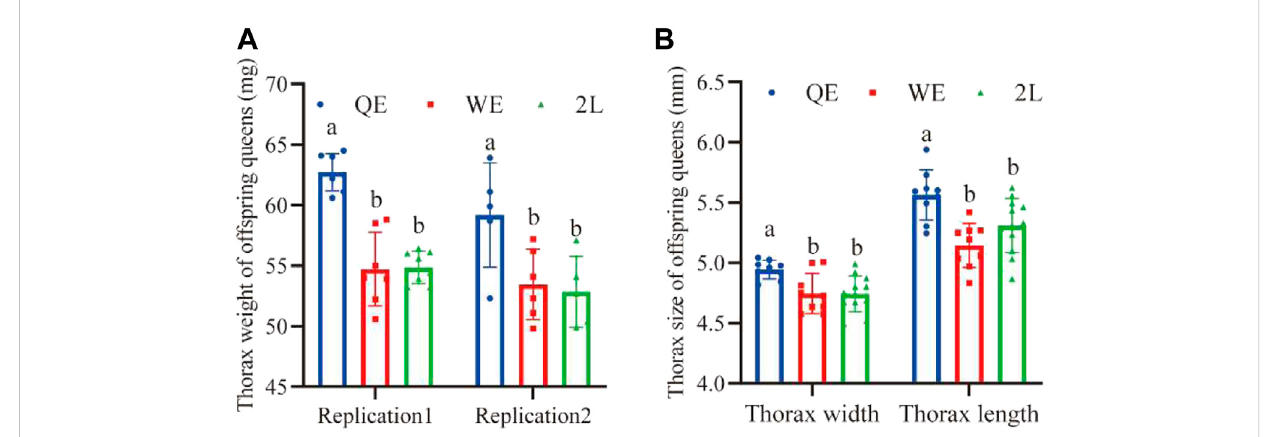
FIGURE 6 (A) Thorax weight and (B) thorax width and length of newly emerged offspring queens from each group (thorax weight: replication 1, n = 7, 7, 8 for QE, WE, 2L, respectively; replication 2, n = 5,6, 5for QE, WE, 2L,respectively. Thorax width: n = 9, 9, 12 for QE, WE, 2L, respectively; Thorax length: n = 9, 9, 12 for QE, WE, 2L,